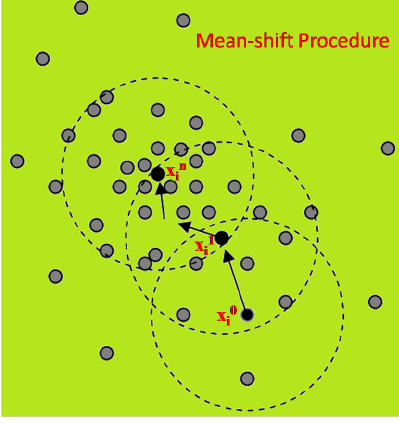
Figure 4. Finding procedure of